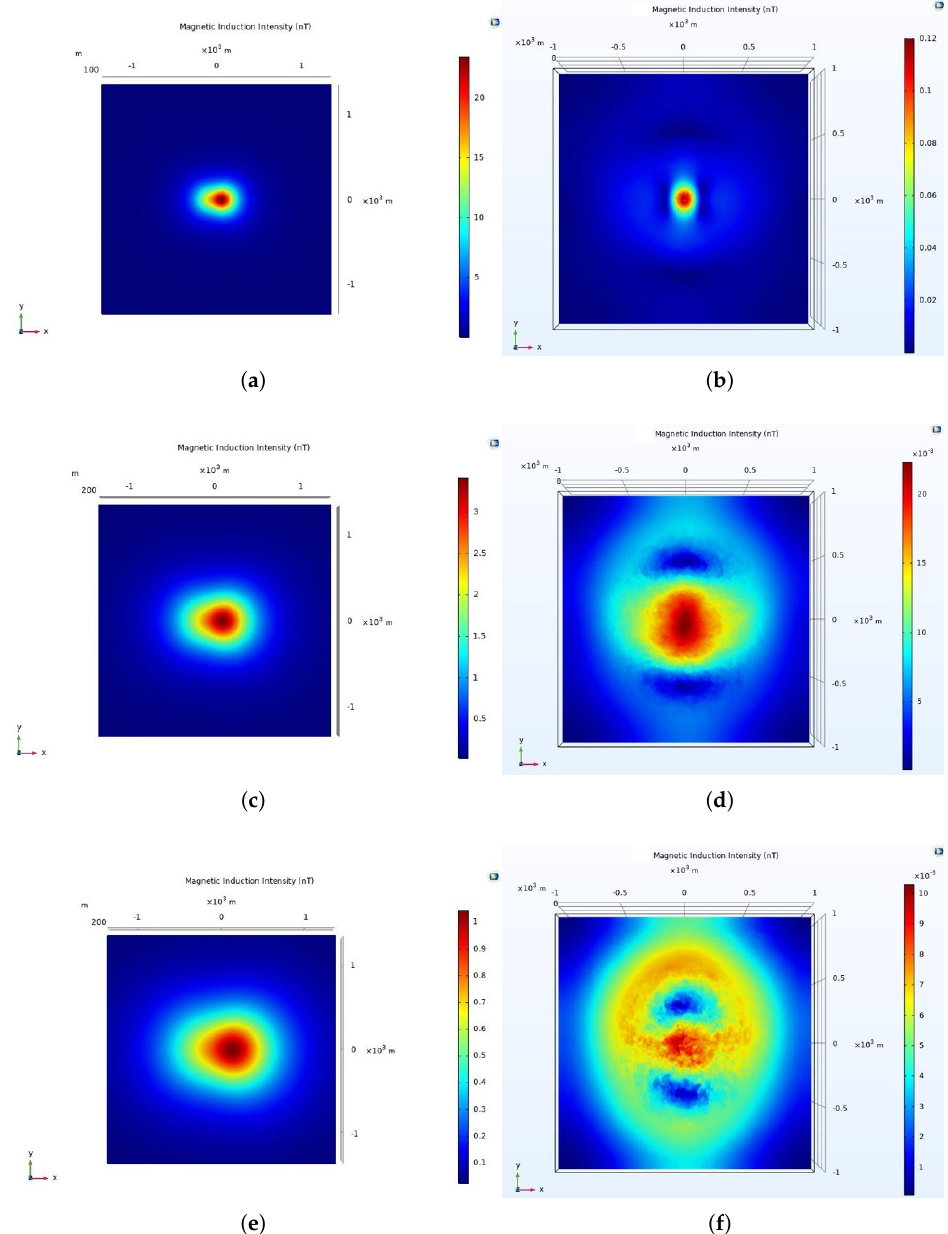
Figure 13. The magnetic induction intensity of multiple measurement plans before and after degauss- ing. ( a ) The spatial scale is 1 (before degaussing); ( b ) The spatial scale is 1 (after degaussing); ( c ) The spatial scale is 2 (before degaussing); ( d ) The spatial scale is 2 (after degaussing); ( e ) The spatial scale is 3 (before degaussing); ( f ) The spatial scale is 3 (after